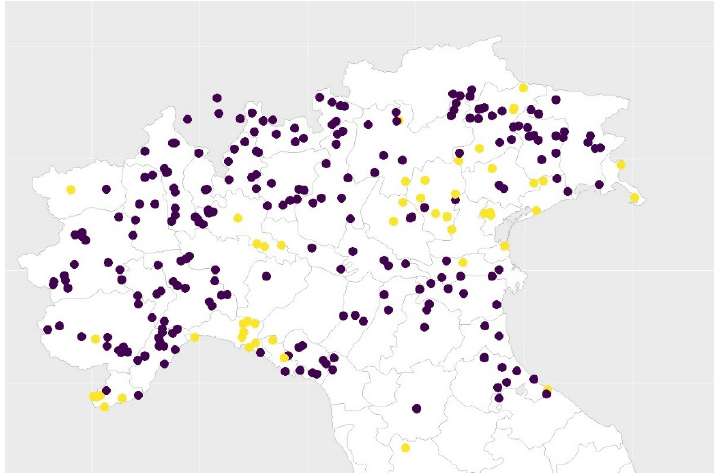
Figure 2. The presence or absence of expletive clitics with weather verbs. Source: Manzini and Sa- voia (2005) + selected data points from the ASIt database. Legenda: absence of expletives vs. presence of expletives.